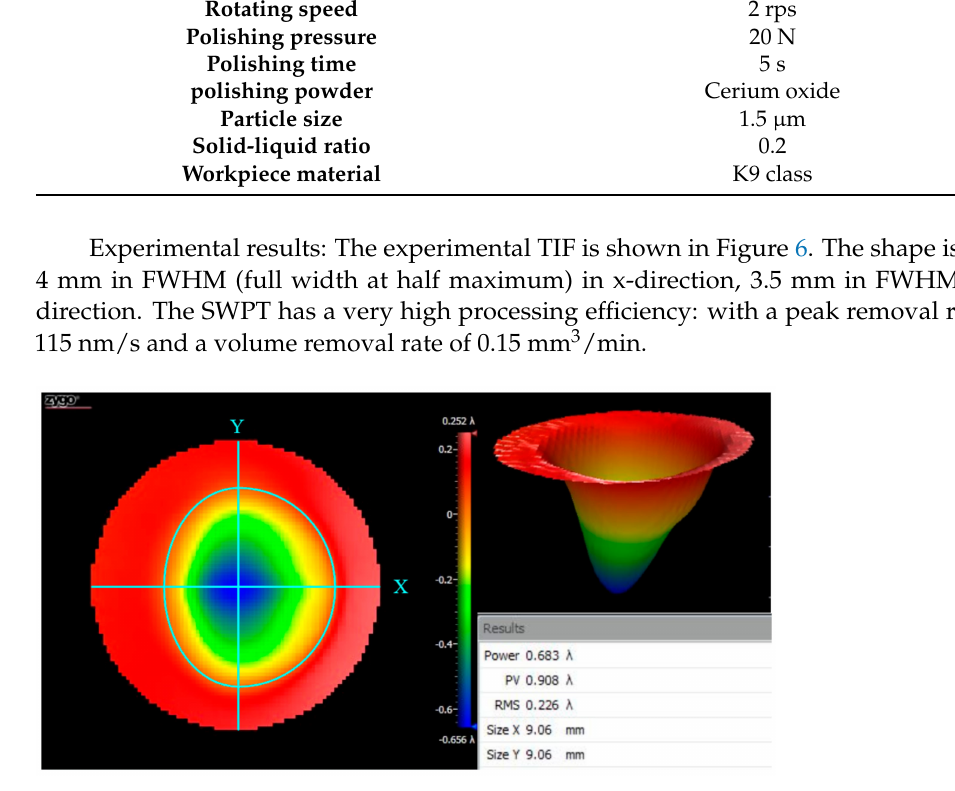
Figure 6. 2D and 3D shapes of the experimental